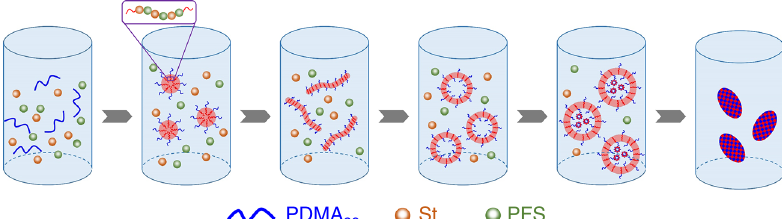
Fig. 6 Schematic illustration of the polymerization-induced self-assembly (PISA) process of PDMA- b -P(St- alt -PFS) in toluene/ethanol with the increasing monomer conversions (for clarity, the earth yellow dots and green dots stand for the monomer styrene (St) and penta fl uorostyrene (PFS), respectively. The blue lines stand for PDMA 29 block and the red lines stand for P(St- alt -PFS) block. Moreover, the light red- and blue-colored regions stand for solvophobic and solvophilic regions in the particles). PDMA poly( N,N